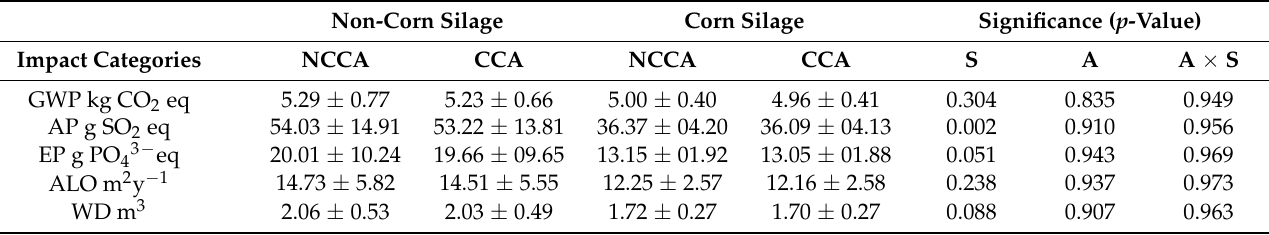
Table 6. Cradle-to-farm gate LCA descriptors. Non-Corn